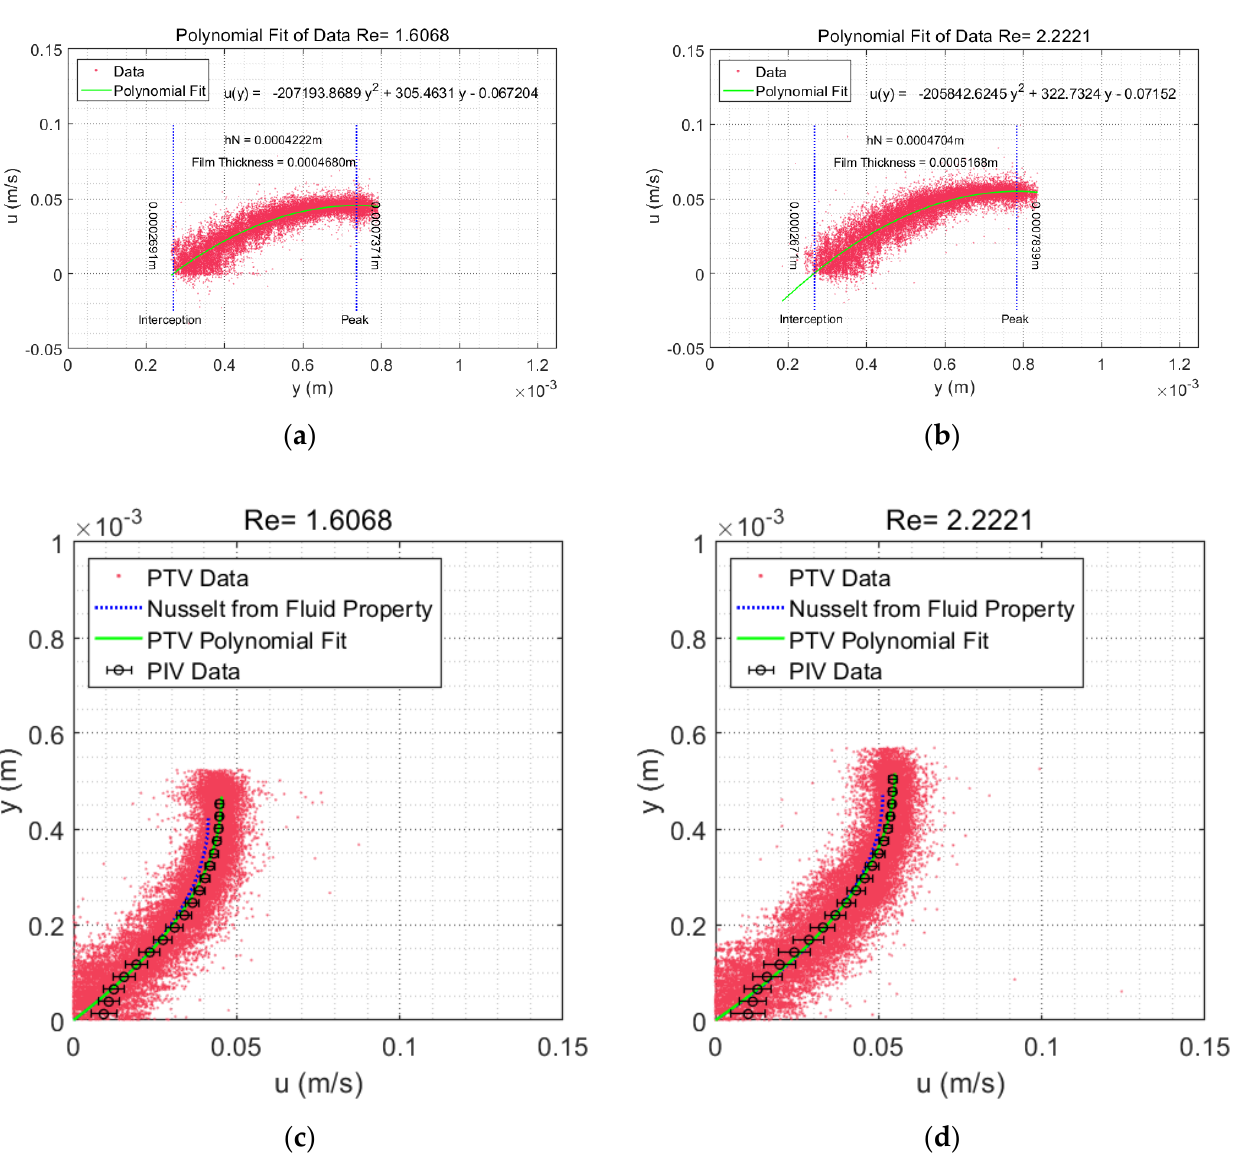
Figure 8. ( a , b ) The PTV velocity fitting results and boundary identification for the Re = 1.61, f = 0 Hz and Re = 2.22, f = 0 Hz glycerol film flow cases; the corresponding adjusted R 2 values are 0.8317 and 0.8336, respectively. ( c , d ) The velocity profile validation and film thickness validation for the Re = 1.61, f = 0 Hz and Re = 2.22, f = 0 Hz glycerol film flow cases, respectively. For the PIV/PLIF results, horizontal error bars illustrate the standard deviation of the measurement data.